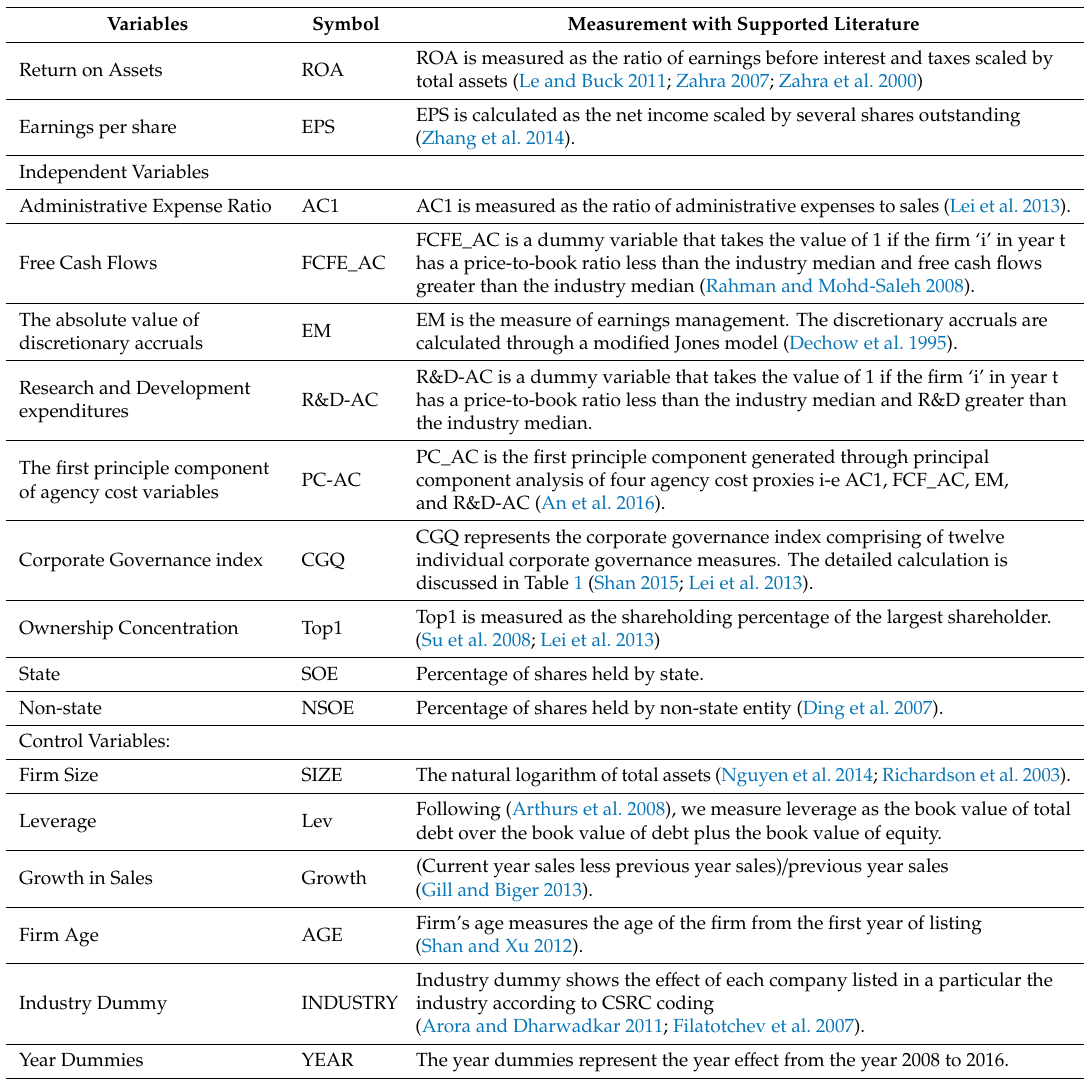
Table 2. Summary of the